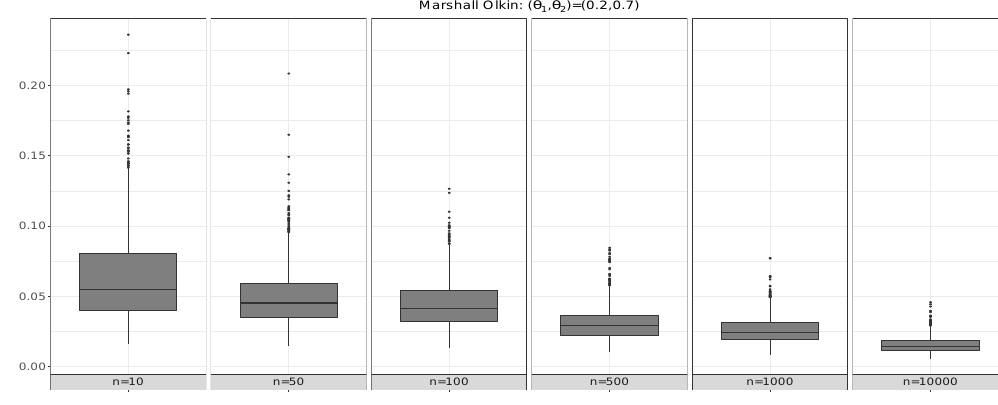
( Y | X ) at level γ = 0.05 . α , γ , M 0.2,0.7